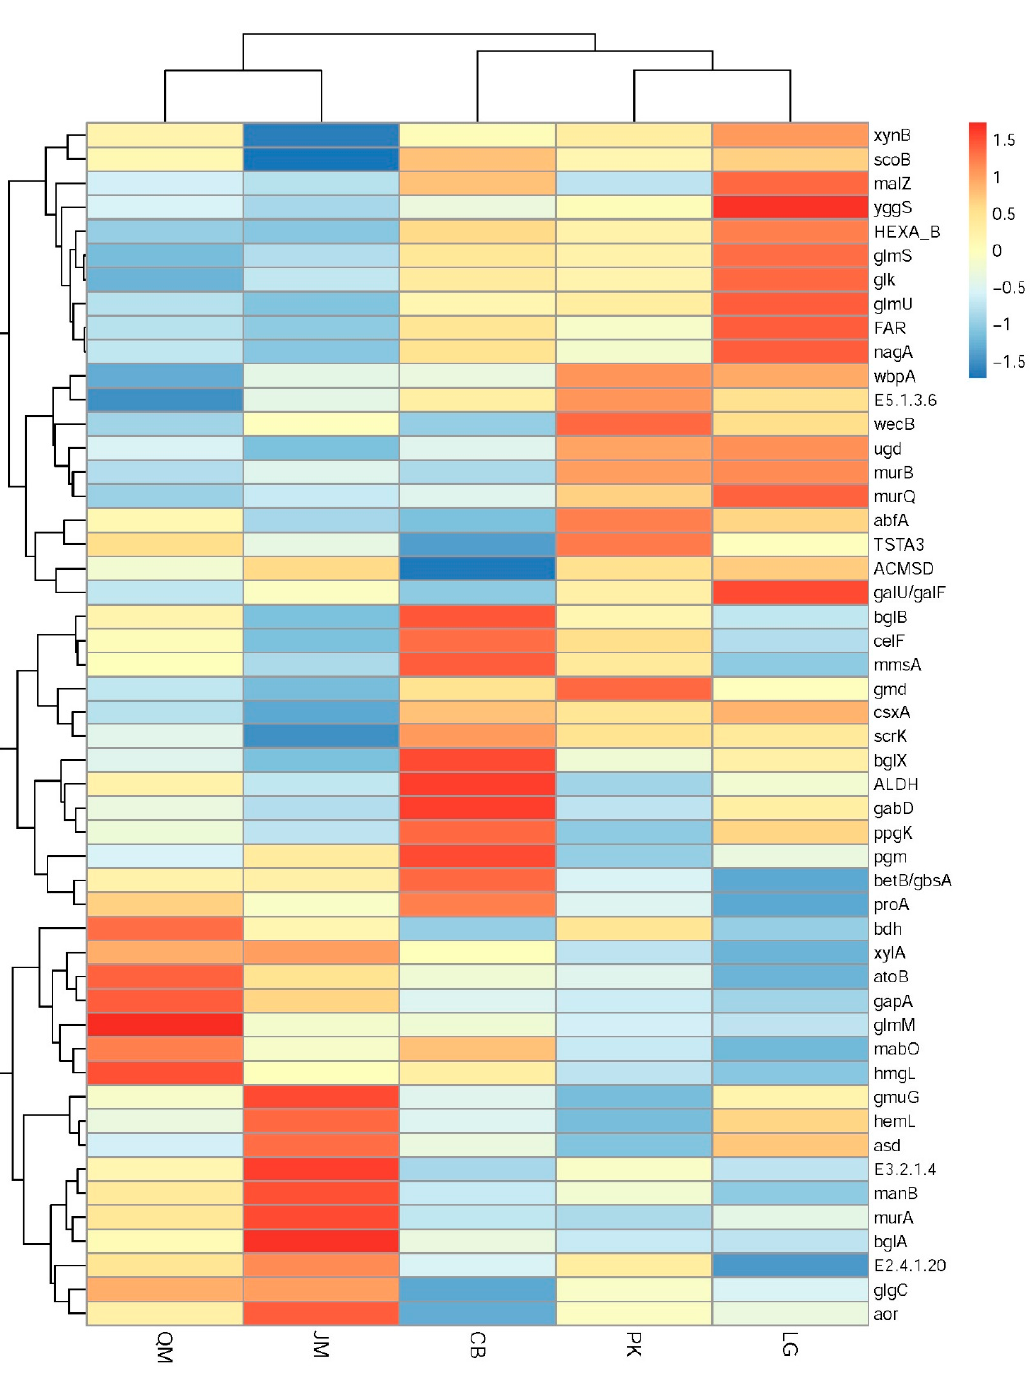
Figure 9. Heatmap and hierarchical cluster analysis based on the relative abundance of the top 50 genes corresponding macro-molecular compounds metabolism of different organic carbon functional group. LG: Larix gmelinii ; PK: Pinus koraiensis ; CB: Conifer-broadleaf forest; JM: Juglans mandshurica ; QM: Quercus mongolica .